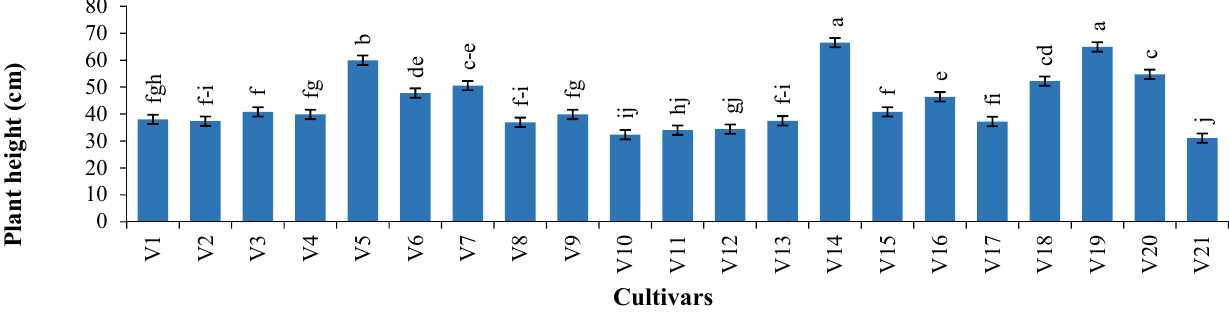
Figure 1. Plant height of different potato cultivars (two years pooled data); values with different lower case letters are significantly different between each other at the 5% level of significance ( p ≤ 0.05); vertical bars represent the standard error of mean values.